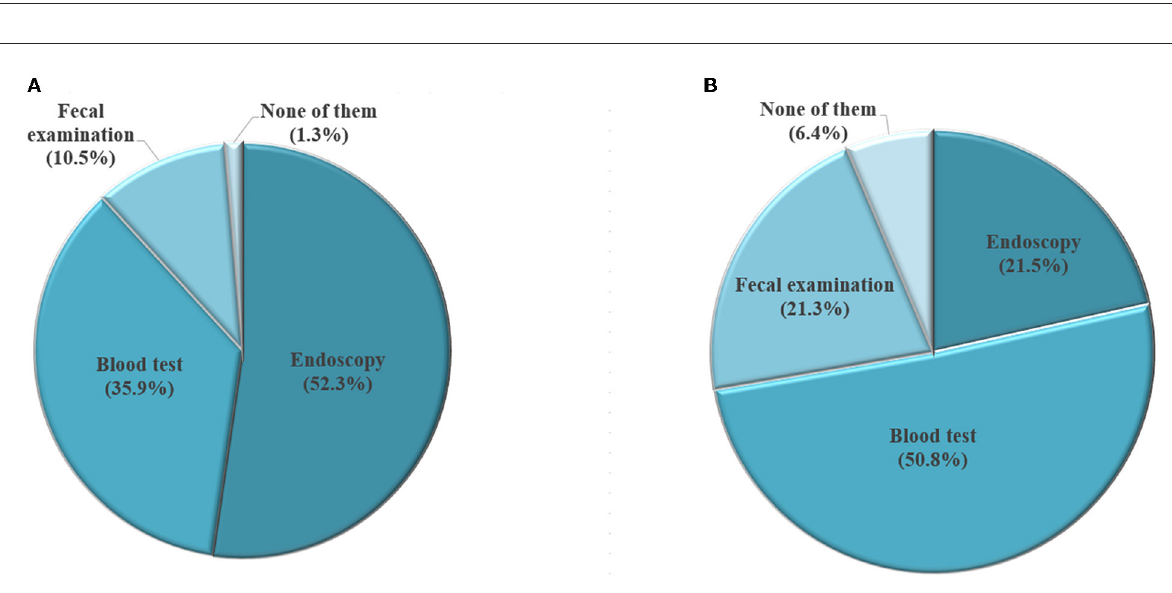
FIGURE4 Selection of screening method among participants who have had gastric cancer screening ( A , N = 1,086) and those who haven’t had gastric cancer screening ( B , N =